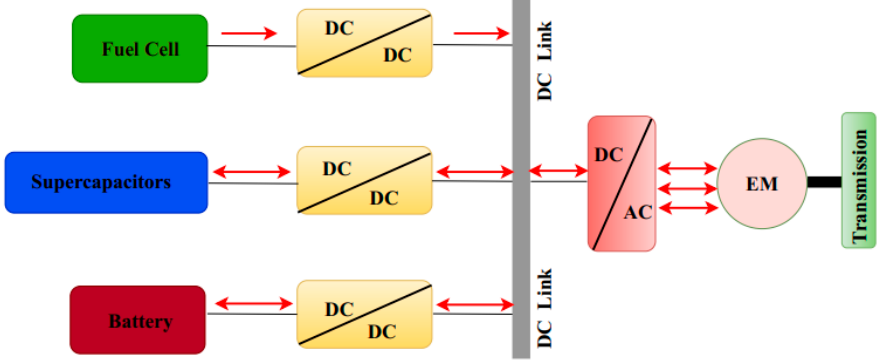
Figure 2. Block diagrams of the electric vehicle.